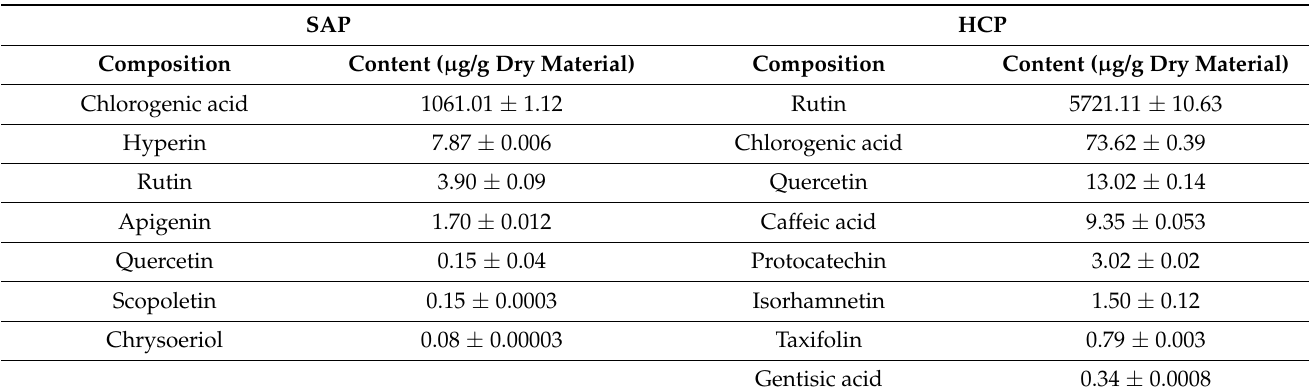
Table 1. The phenolic compositions of SAP and